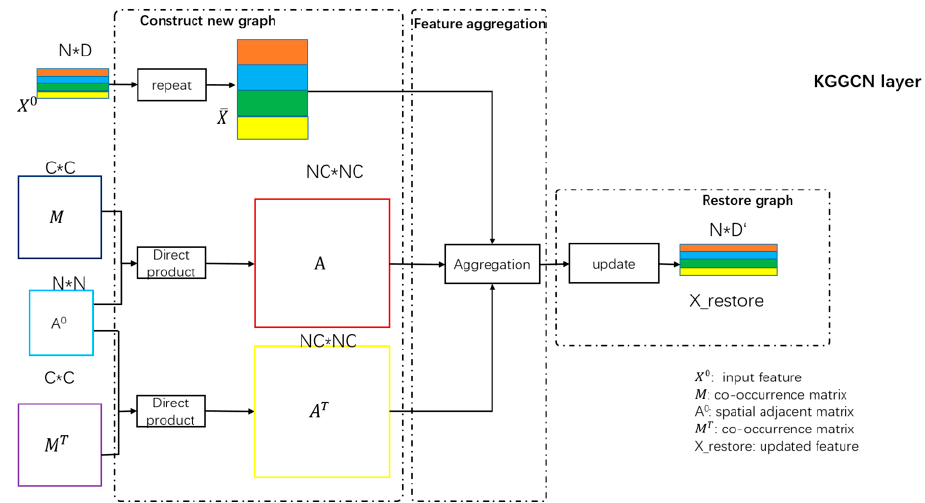
Figure 12. Structure of KGGCN layer. The input of the KGGCN layer includes four parts: X 0 denotes the node features in the original graph, X 0 ∈ R N × D , where N is the number of nodes, and D is the dimension of the feature. M denotes the matrix of the co-occurrence probability, and M ∈ R C × C , where C is the number of categories. M T denotes the transpose of M . A 0 denotes spatial adjacency matrix, and A 0 ∈ R N × N .